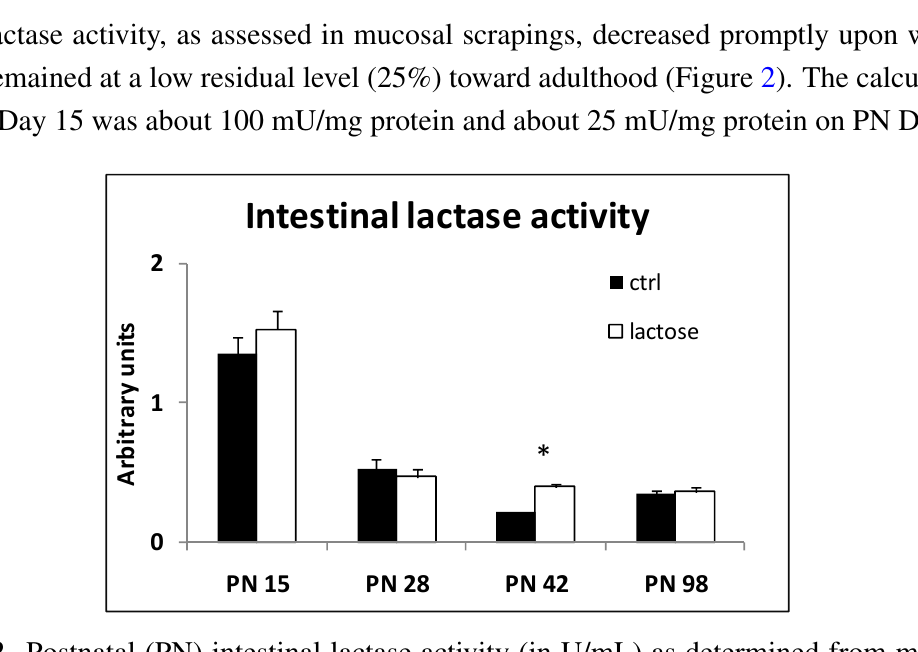
Figure 2. Postnatal (PN) intestinal lactase activity (in U/mL) as determined from mucosal scrapings at various time points; control ( n = 2), lactose ( n = 7–8) at each time point; * p < 0.05.